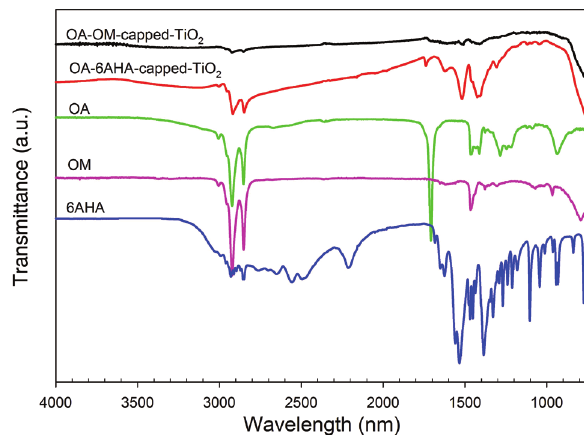
Figure 2 Powder XRD patterns of OA-OM-capped-TiO 6AHA-capped-TiO